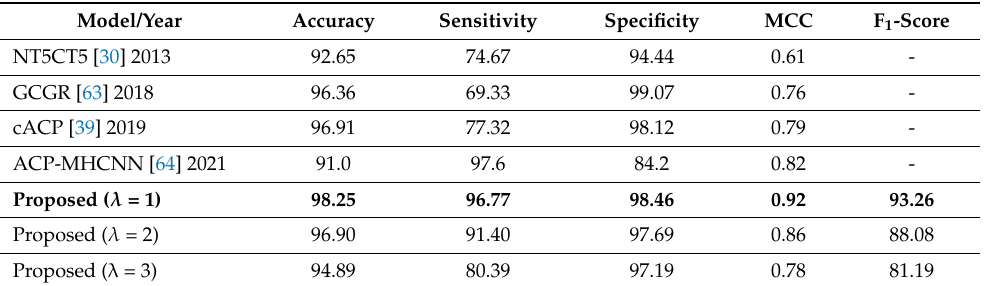
Table 6. Performance comparison of the proposed model with SOTA methods using PSD1 dataset, where the best result is highlighted in